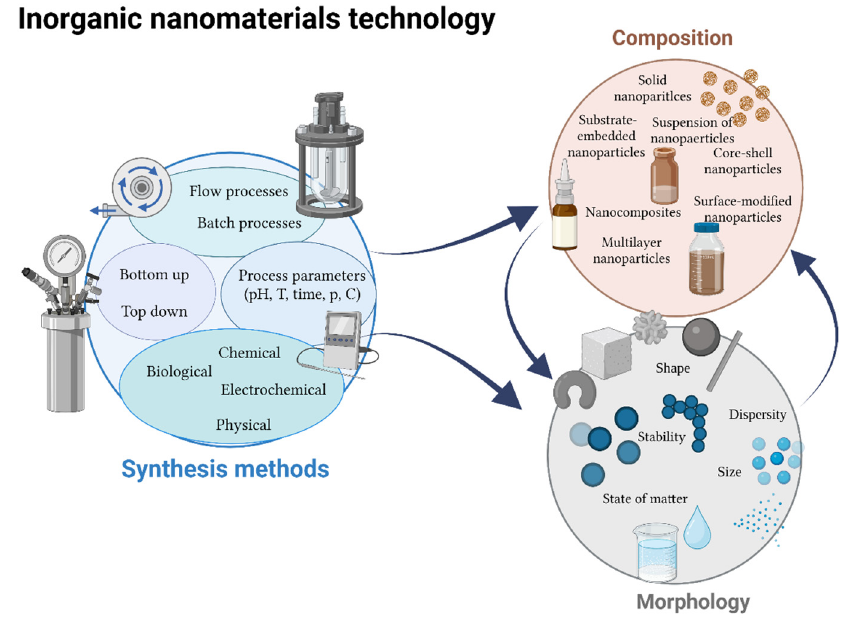
Figure 3. In fl uence of inorganic nanoparticles preparation methods on their physico-chemical prop- Figure 3. Influence of inorganic nanoparticles preparation methods on their physico-chemical erties (Created with BioRender.com access: 10 March 2023). properties (Created with BioRender.com access: 10 March